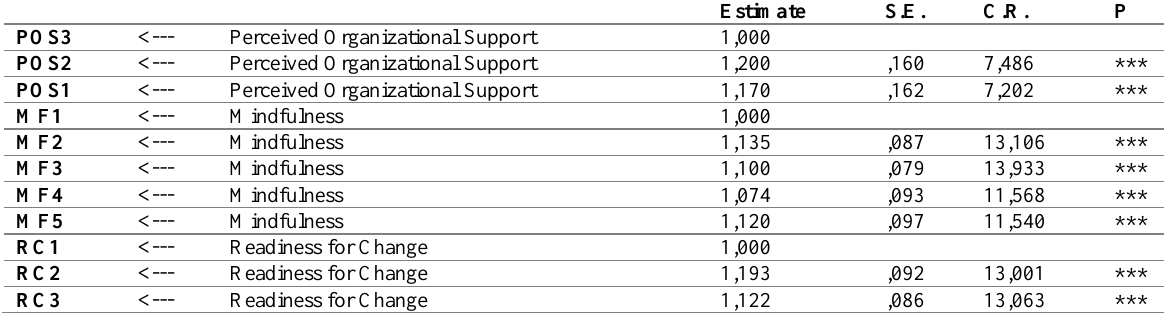
Table 4: Results of Convergent Validity Test